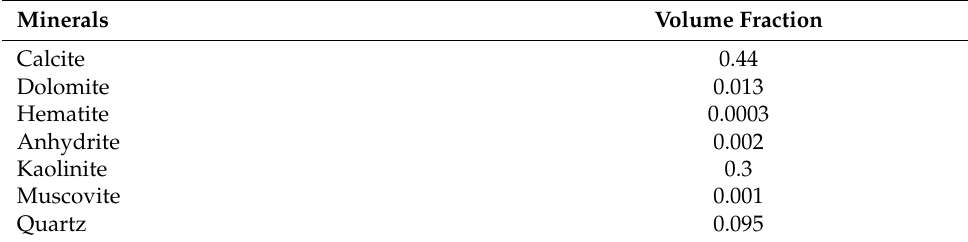
Table 2. Initial mineral volume fractions of the confining cover.